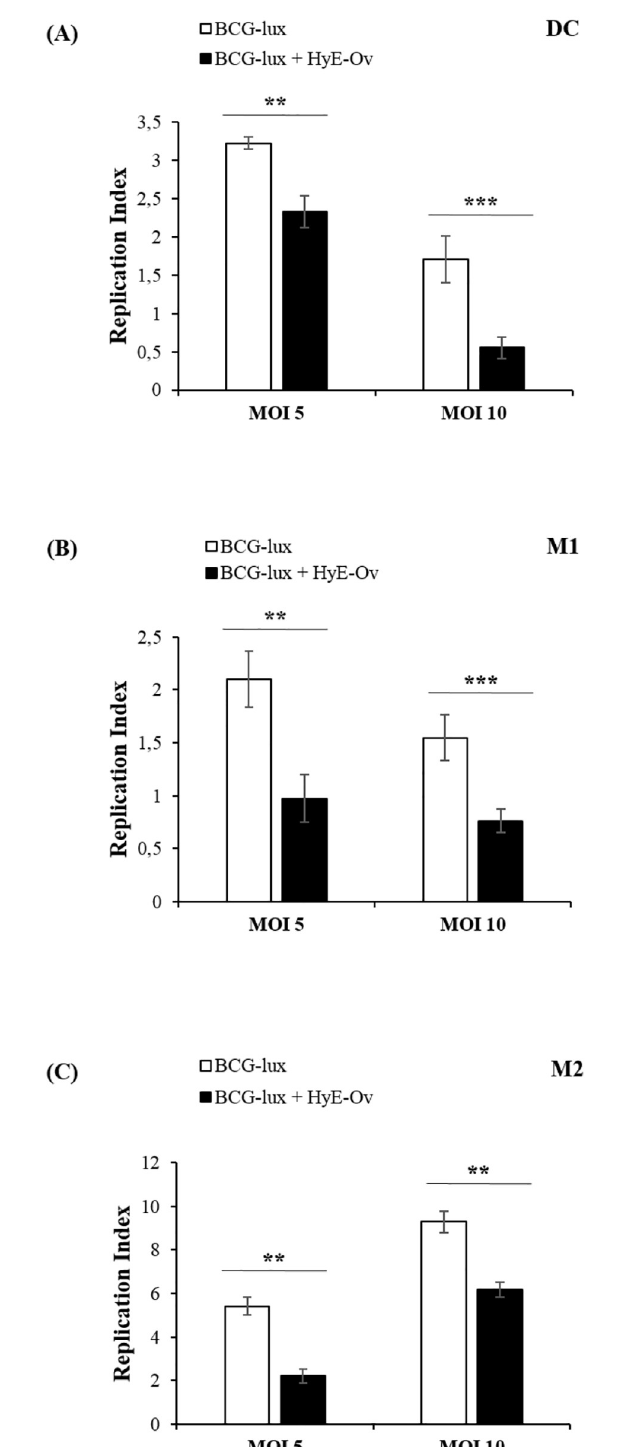
Fig 1. HyE-Ov promotes intracellular mycobacterial killing. DC (A), M1 (B) and M2 (C) cells (5x10 5 /well) were infected with BCG-lux for 3 hours (MOI 5 and 10) and stimulated or not with HyE-Ov (3 mg/ml of equivalent plant material). Mycobacterial growth was evaluated by luminometric analysis after 3 days (t3) from stimulation (t0). Data are shown as means ± Standard Deviation (SD) of the ratio t3/t0 of RLU values from triplicate cultures and are representative of at least 3 independent experiments performed on cells from different donors. �� p < 0.01 and ��� p < 0.0001 in comparison with non-stimulated infected cells.